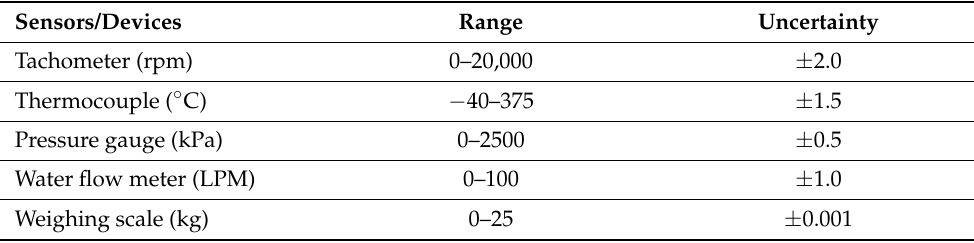
Table 4. Uncertainties of the AAC system sensors and measurement